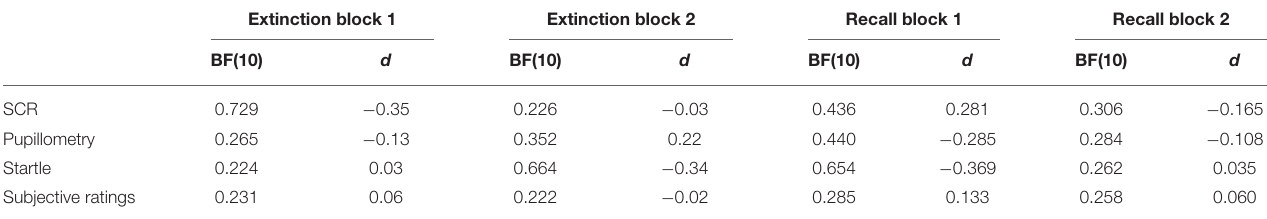
TABLE 3 | Differential physiological responding (CS + shock versus CS-) between OCD and HC during extinction and recall. Extinction block 1 Extinction block 2 Recall block 1 Recall block